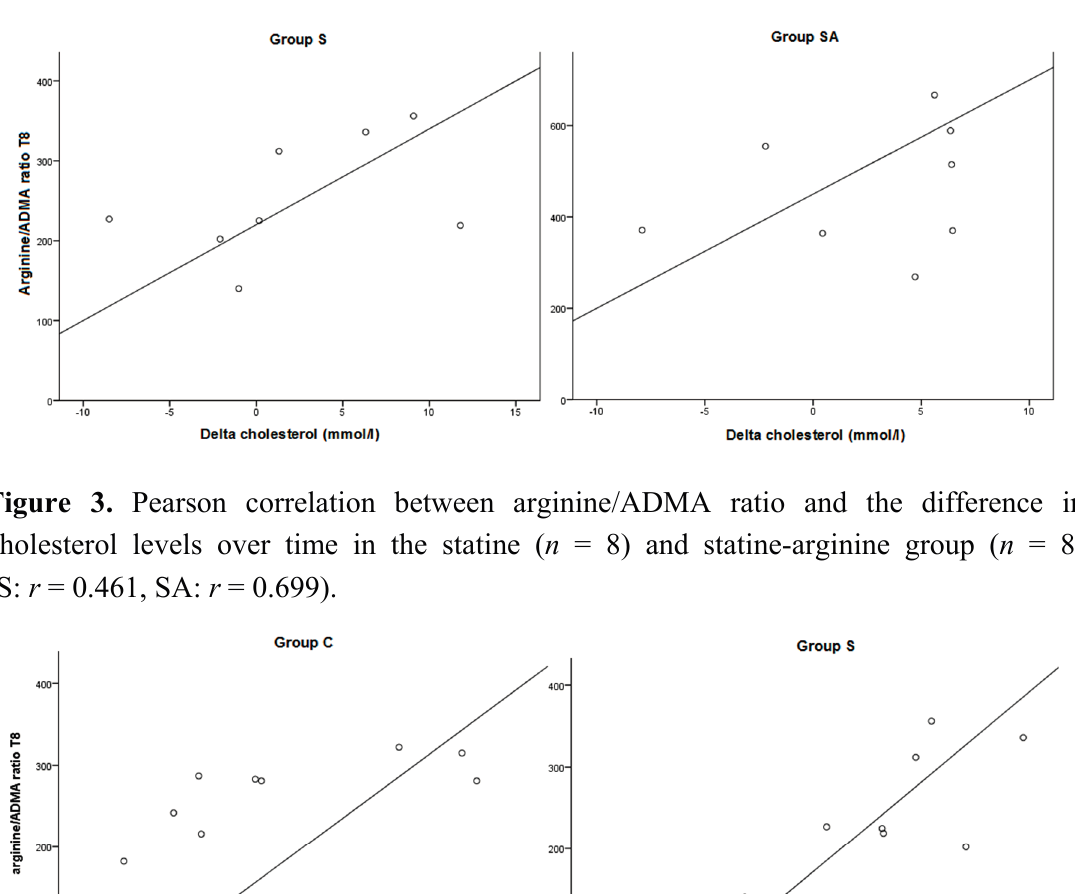
Figure 2. Pearson correlation between ∆ ADMA (T0–T8, n = 4 per group) and aortic lesions in the distal aorta ( r = 0.677, p = 0.01) and total aorta ( r = 0.599, p = 0.03).